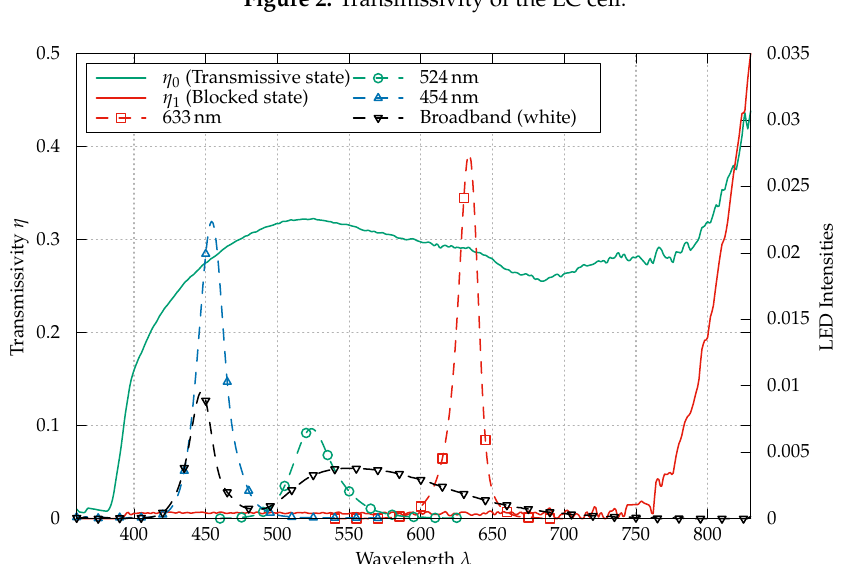
Figure 2. Transmissivity of the LC cell.